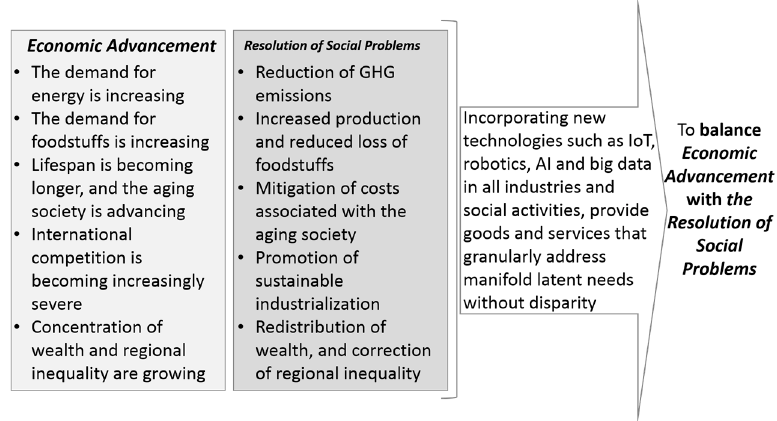
Figure 2. Society 5.0 Advantages [53].